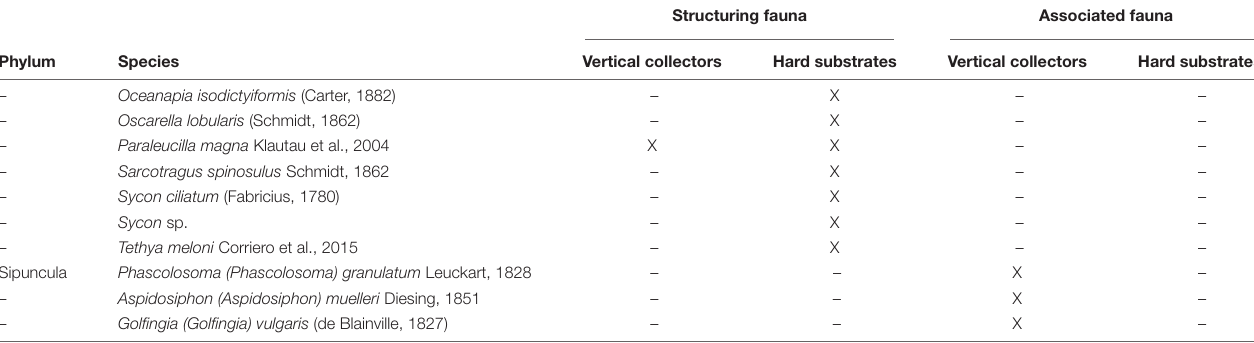
development of the macrofouling assemblage was significantly affected by the sampling time, stations, and their interaction Seasons. The post hoc pairwise test highlighted that all the stations in 2018 had a different composition while in 2019 the differences remained within the stations subjected to the bioremediation treatment (A3 and A6) and within the control stations (B3 and B6) with no differences between the treatment and